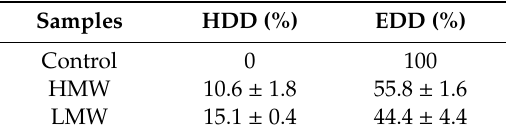
Table 5. Hydrolytic (HDD) and enzymatic (EDD) degree of degradation for control sca ff olds and collagen sca ff olds with HMW and LMW chitosan after 4